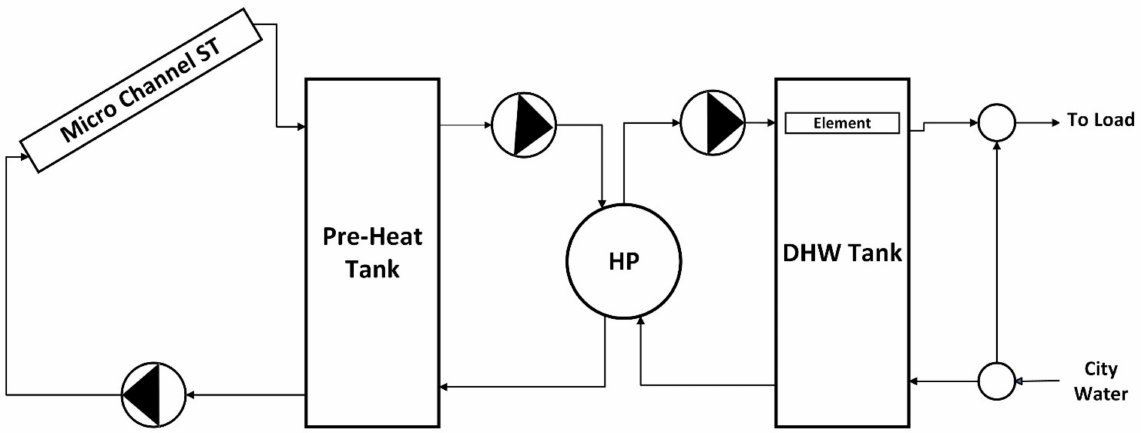
Figure 3. Schematic of MCST-HP DHW